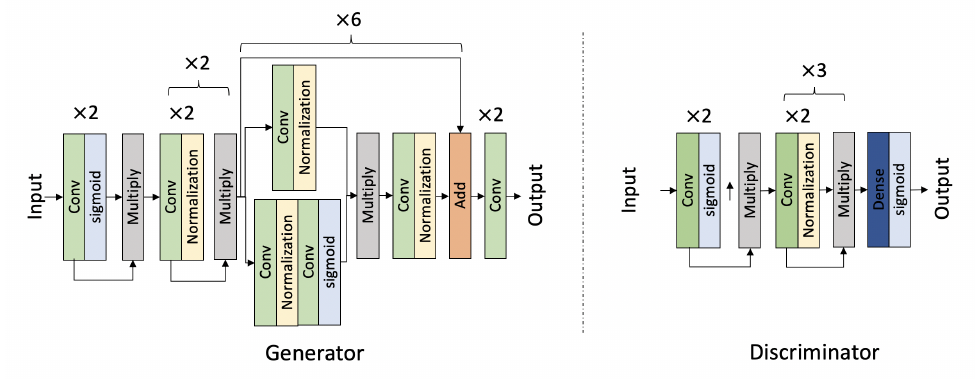
Figure 1. Neural networks for CycleGAN-based emotional voice conversion